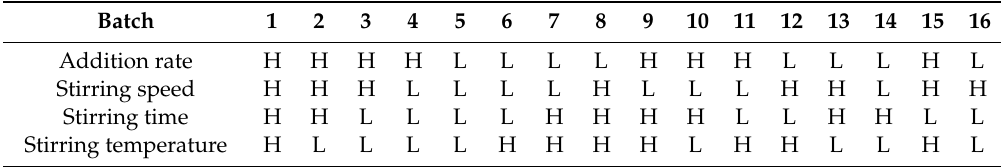
Table 4. Design of experiment (DoE) of process parameters for phytosome preparation. H and L denote high and low, respectively.